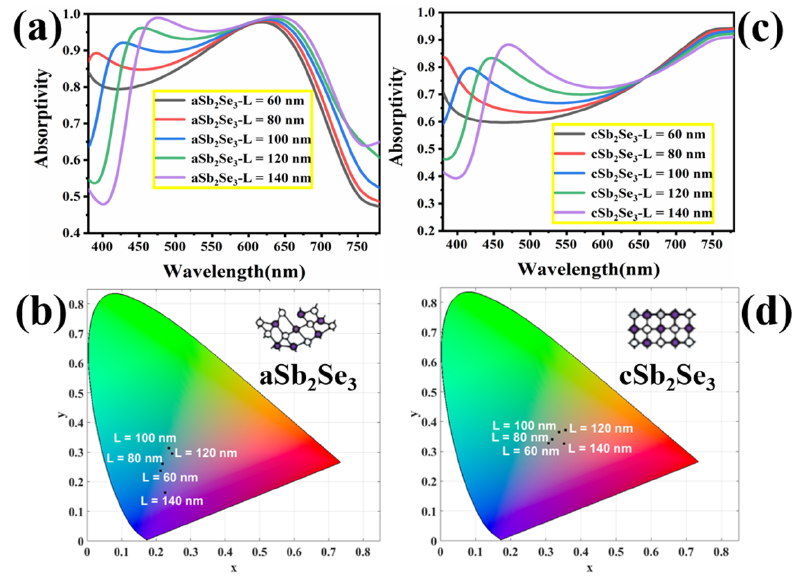
Figure 10. Absorption spectra ( a ) and corresponding chromaticity diagram coordinates ( b ) for different structural parameters ( L ) under the amorphous state; absorption spectra ( c ) and corresponding chromaticity diagram coordinates ( d ) for different structural parameters ( L ) under the crystalline state.